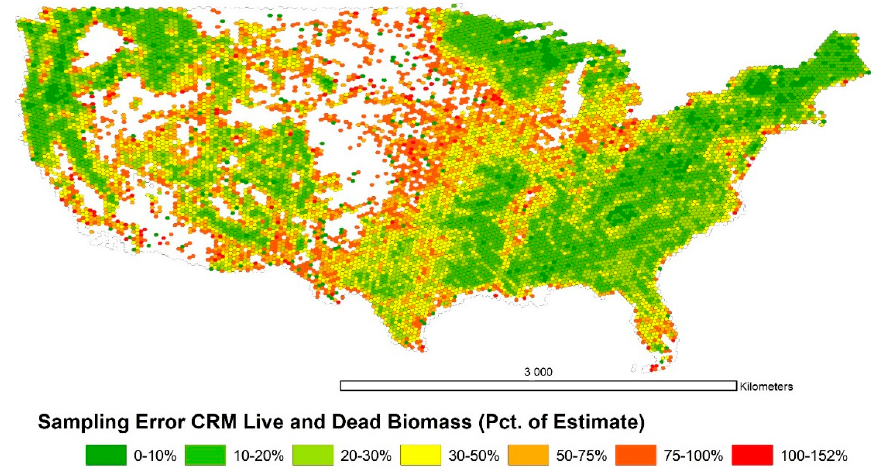
Figure 2. FIA hex-level estimates of the standard error of mean CRM biomass.